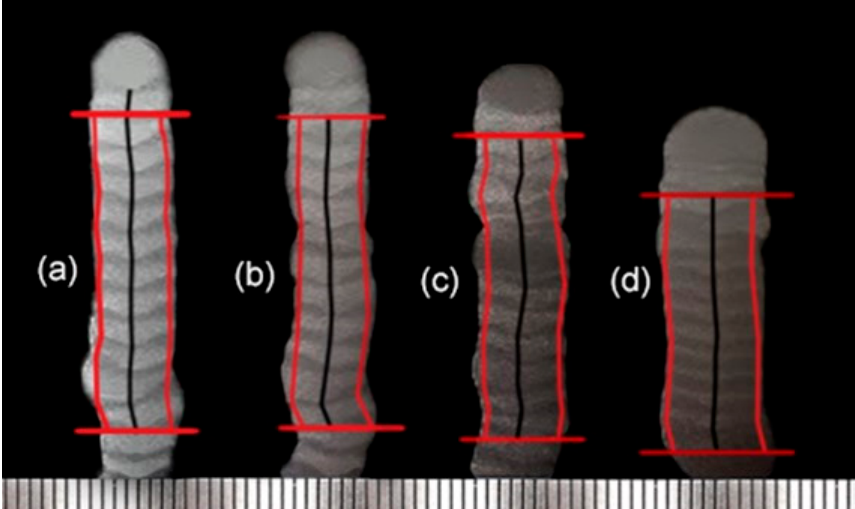
Figure 12. Cross-sections of the actual walls: ( a ) WFS = 5 m/min, TS = 41 cm/min; ( b ) WFS = 5.1 m/min, TS = 42 cm/min; ( c ) WFS = 6.1 m/min, TS = 50 cm/min; and ( d ) WFS = 6.5 m/min, TS = 53.5 cm/min (TS stands for travel speed, while WFS represents wire feed speed).